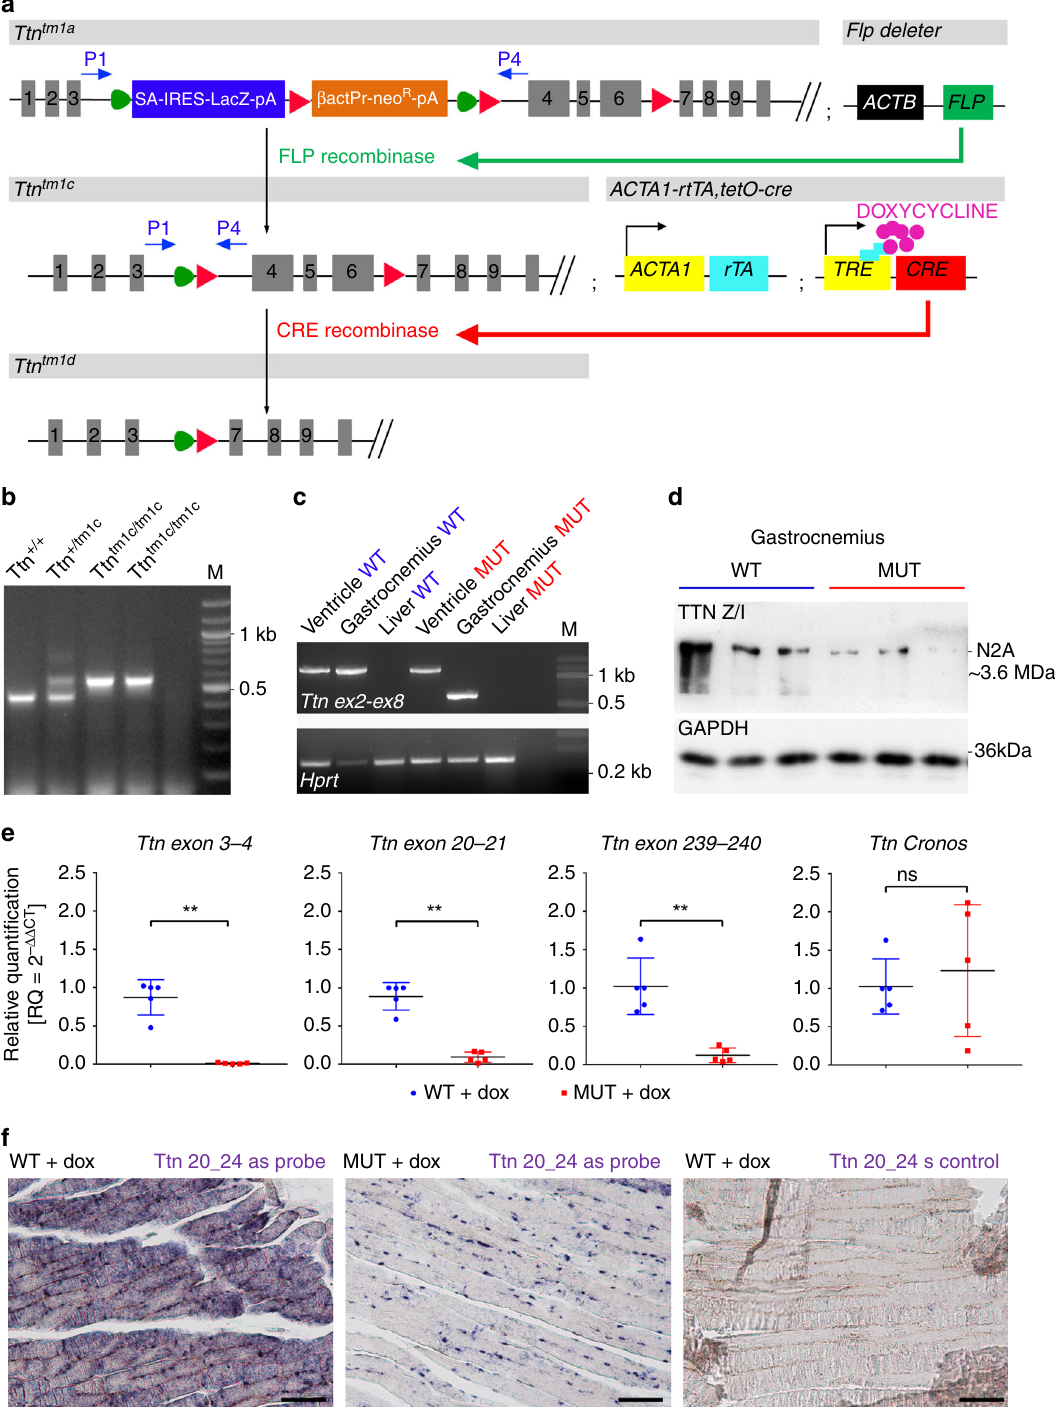
Histological analysis by hematoxylin-and-eosin staining of skeletal muscle revealed reduced myo fi ber diameters and some centralized nuclei in MUT (Fig. 2c), indicating muscle atrophy. Both the number of centralized nuclei (Fig. 2d) and the mean fi ber cross-sectional area (Fig. 2e) were already altered in MUT muscles after 21 days of dox-treatment. TTN depletion disrupts the normal striated sarcomere pattern . Immunostaining against different TTN epitopes (Fig. 3a) on paraf fi n sections of M. gastrocnemius showed increased